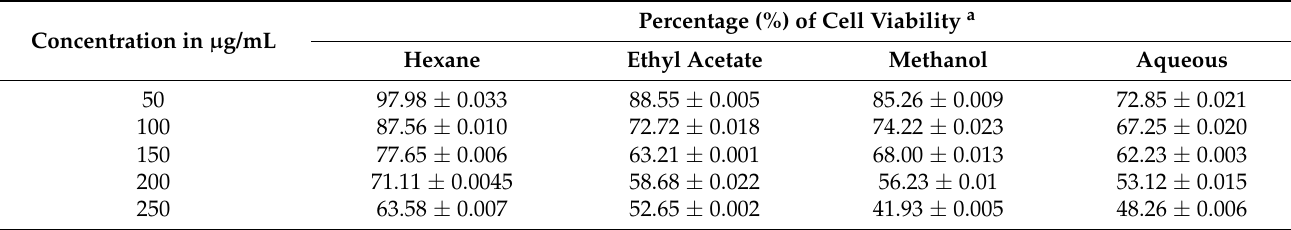
Table 1. Cytotoxicity of different solvent extracts of C. colocynthis against L929 cell line. Concentration in µ